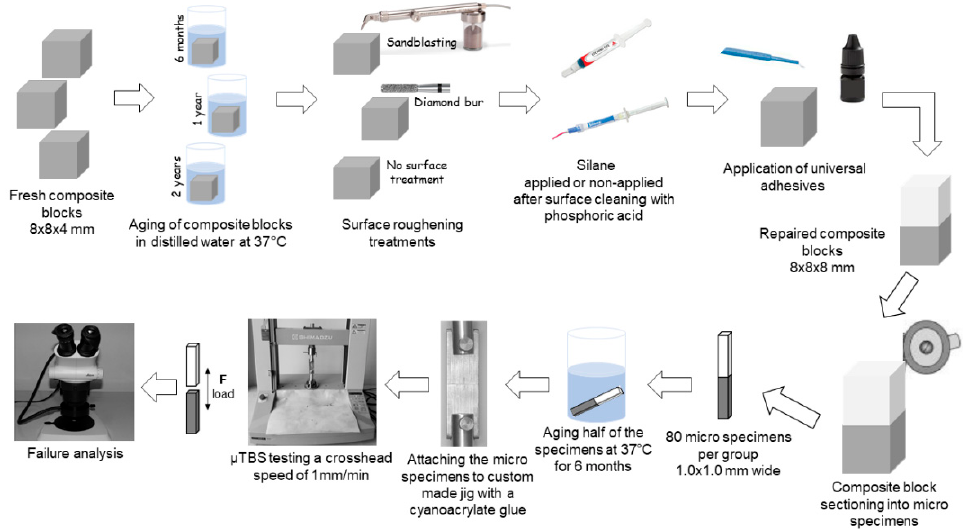
Figure 1. Schematic illustrating the experimental study design.